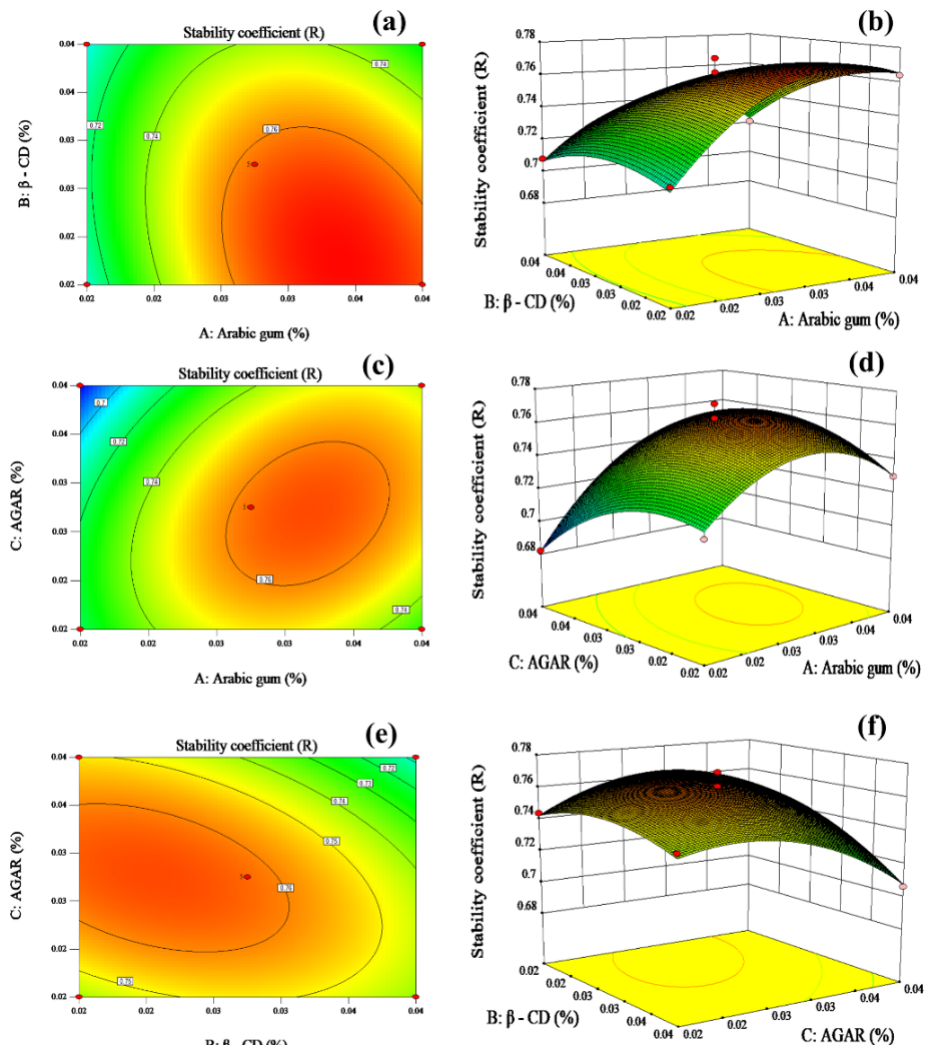
Figure 3. Influence of interaction between various factors on the stability of milk tea. 2 ‐ D contour plots and 3 ‐ D response surface of β‐ CD and Acacia gum ( a , b ), AGAR and Acacia gum ( c , d ), AGAR and β‐ CD ( e , f ).